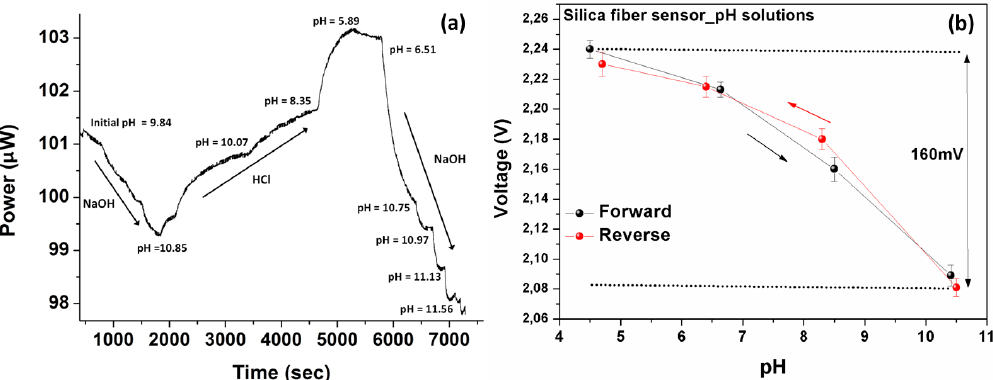
Figure 7. ( a ) Measured optical response of the silica fiber sensor standard pH solutions following dynamic changes in solutions’ acidity. The dynamic response of the sensor in successive solution’s acidity changes is clearly demonstrated. ( b ) The electrically converted response of the silica optical fiber sensor, as a function of the pH, exhibiting an almost linear and also reversible response with an adequate 160 mV range.